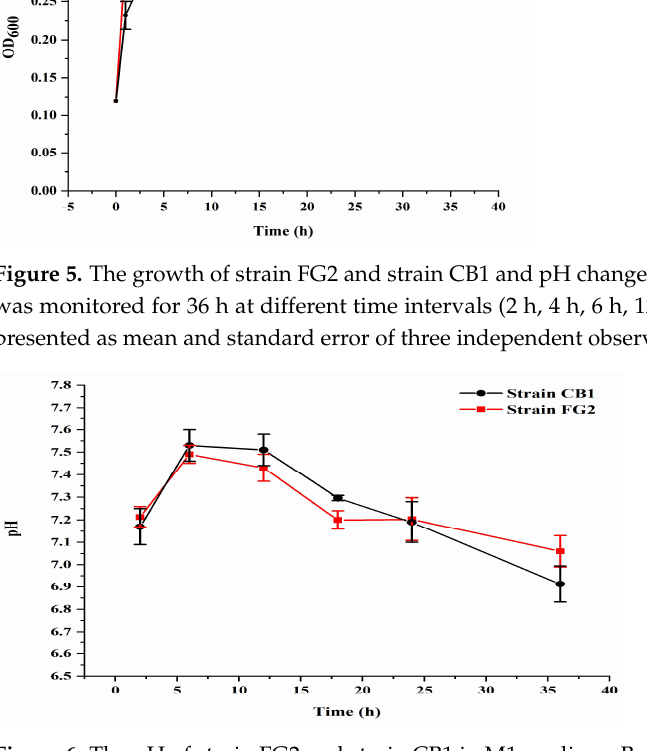
Figure 6. The pH of strain FG2 and strain CB1 in M1 medium. Bacterial growth was monitored for 36 h at different time intervals (2 h, 6 h, 12 h, 18 h, 24 h, and 36 h). Data is presented as mean and standard error of triplicates.